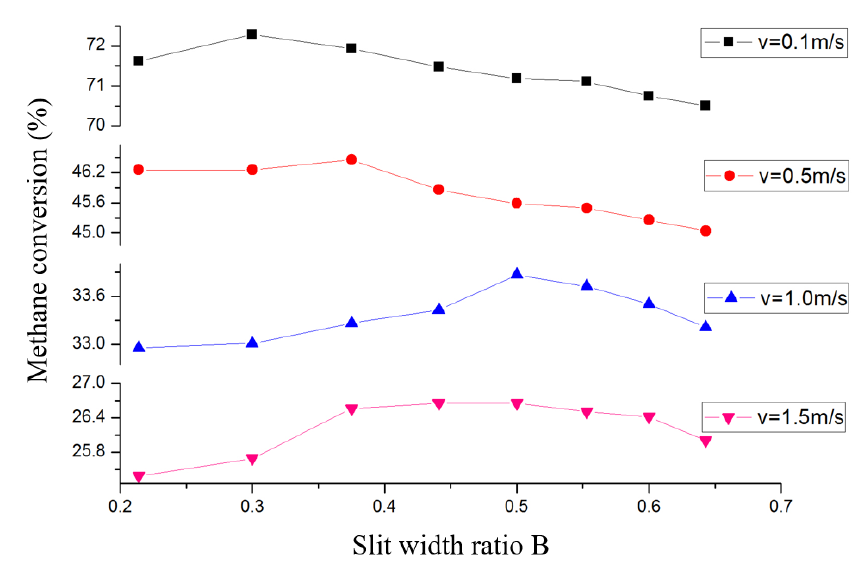
Figure 7. Effect of slot width ratio at different velocities on methane conversion.